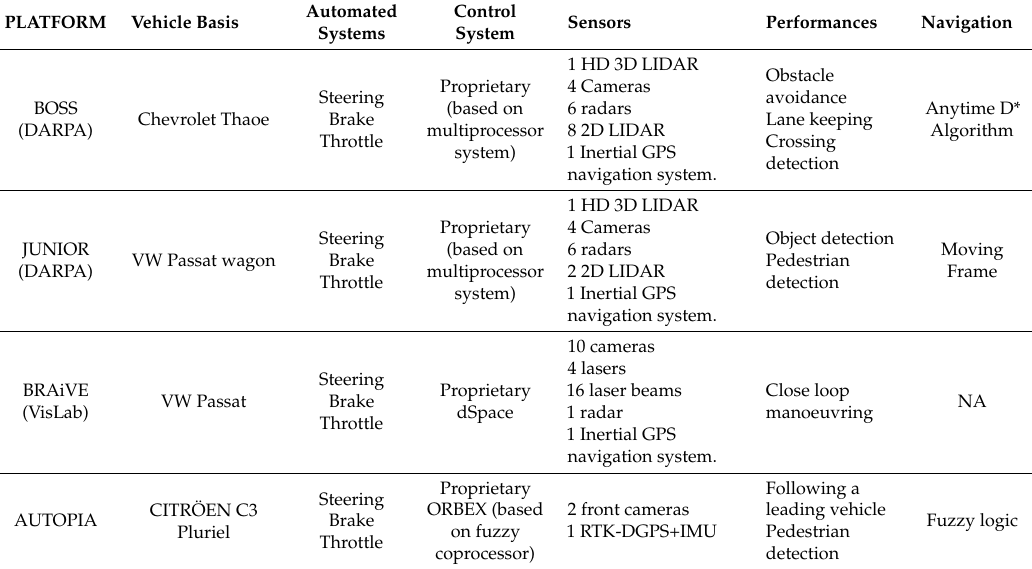
Table 3. Some platforms for autonomous driving